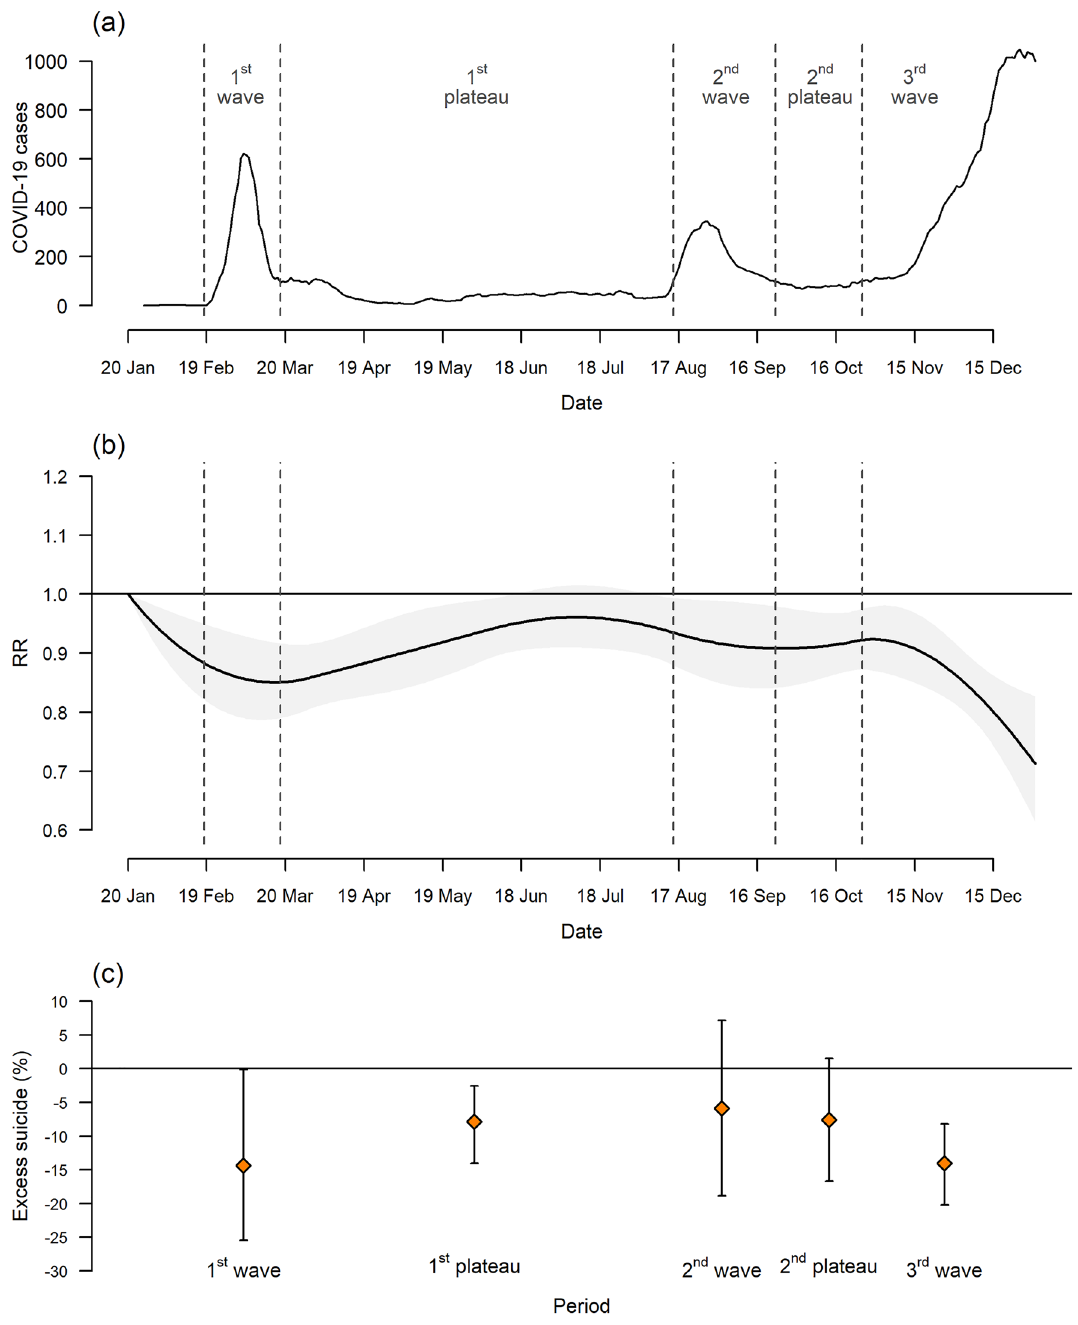
Figure 1. Temporal trend in 7-day moving average of confirmed COVID-19 cases ( a ), excess risk (relative risk, RR) of suicide with a band corresponding to the 95% eCI ( b ), and percent excess of suicide by period ( c )